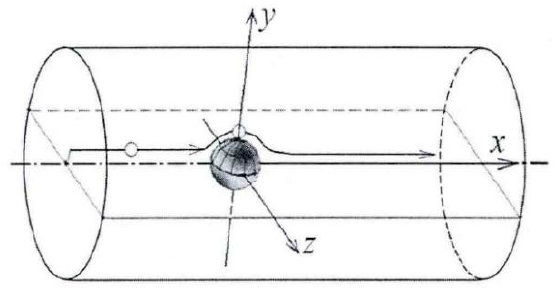
Figure 4. Geometry of the calculation area.